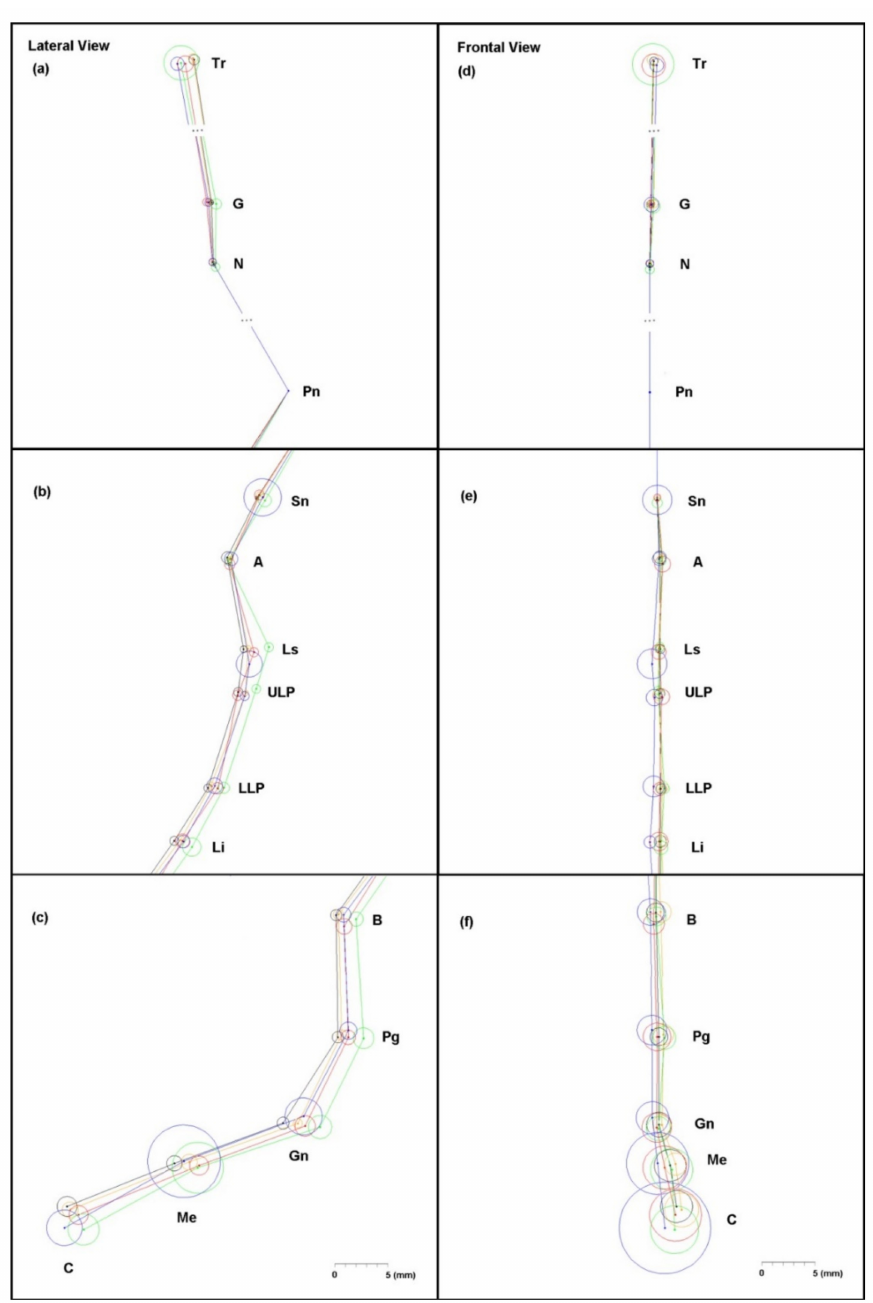
Figure 4. Lateral ( a , b , c ) and frontal ( d , e , f ) views of distributions of the landmarks: D+10 ◦ ( red ),